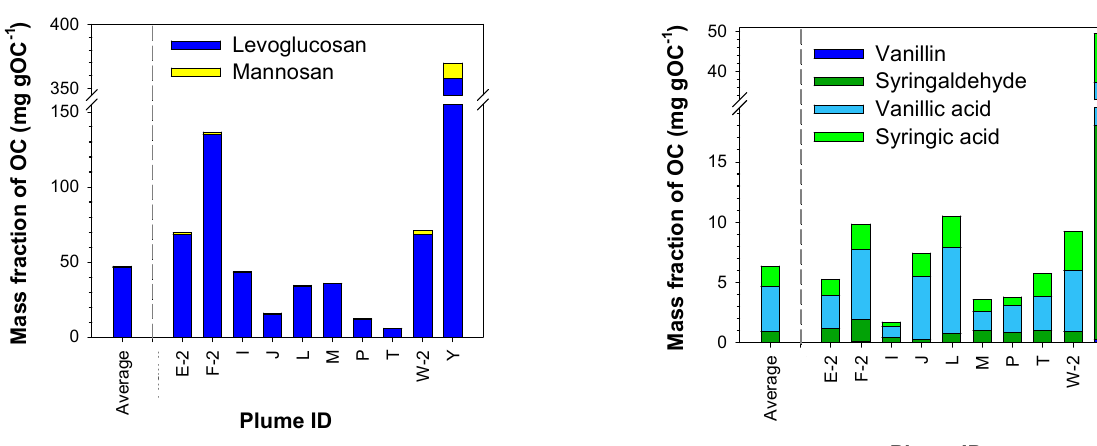
Figure 5. Organic carbon mass fractions of select anhydrosugars for study average and selected individual plumes. Plume Y was not included in average calculation as discussed in Sect. 2.1. On average, the galactosan mass fraction was 0.14mggOC − 1 (maxi- mum = 0.77mggOC − 1 ) ; due to its low concentrations, it was not included in the plot.